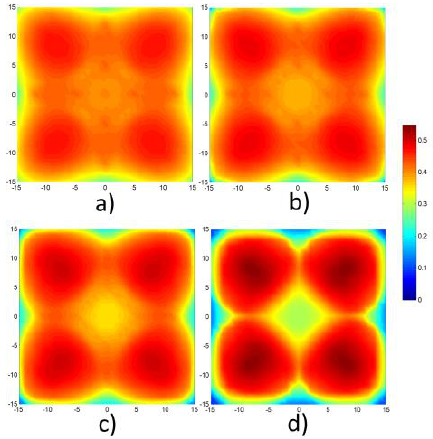
Fig. 5. FAST angular efficiency distribution for four different camera-mirror distances, with average efficiency value in FoV. X-axis is azimuth angle and Y-axis is elevation angle. Colour scale in relative value. 100 % is aperture input power. Mirror-camera distance of 710 mm was chosen as the best optical design for